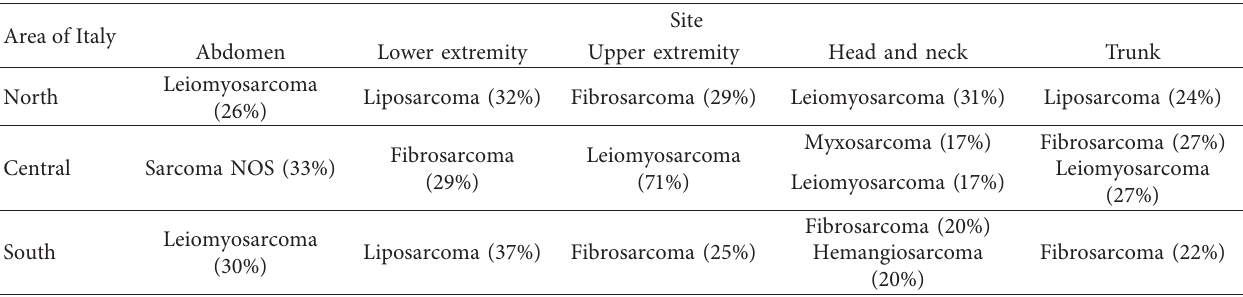
Table 4: Most frequent (% of total) soft tissue sarcomas morphologies at different sites by Italian geographic area. Cases diagnosed in 2009–2012 and archived in 15 Italian population-based cancer registries affiliated to AIRTUM.